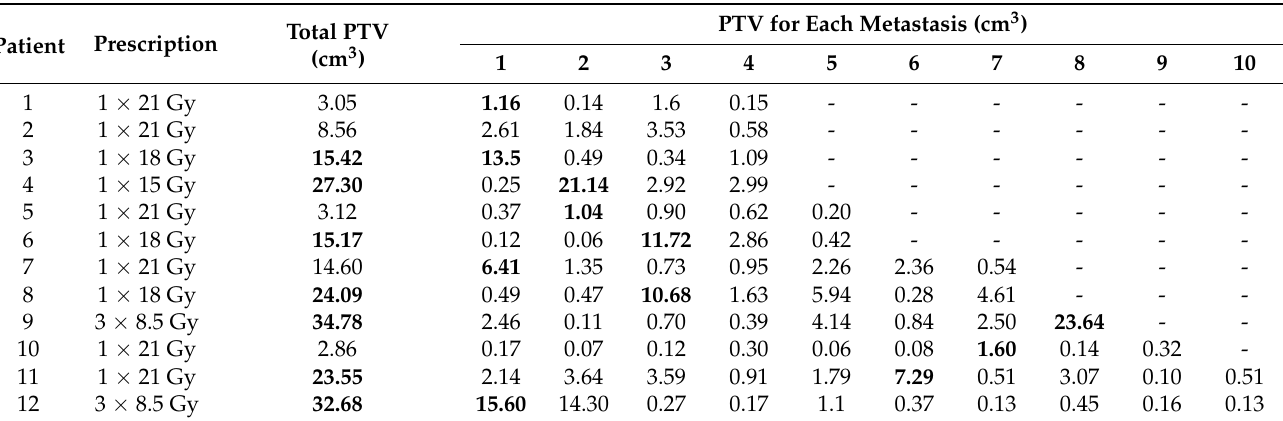
Table 1. The number of metastases, the total planning target volume (PTV), all PTVs, and the prescription dose for the 12 studied